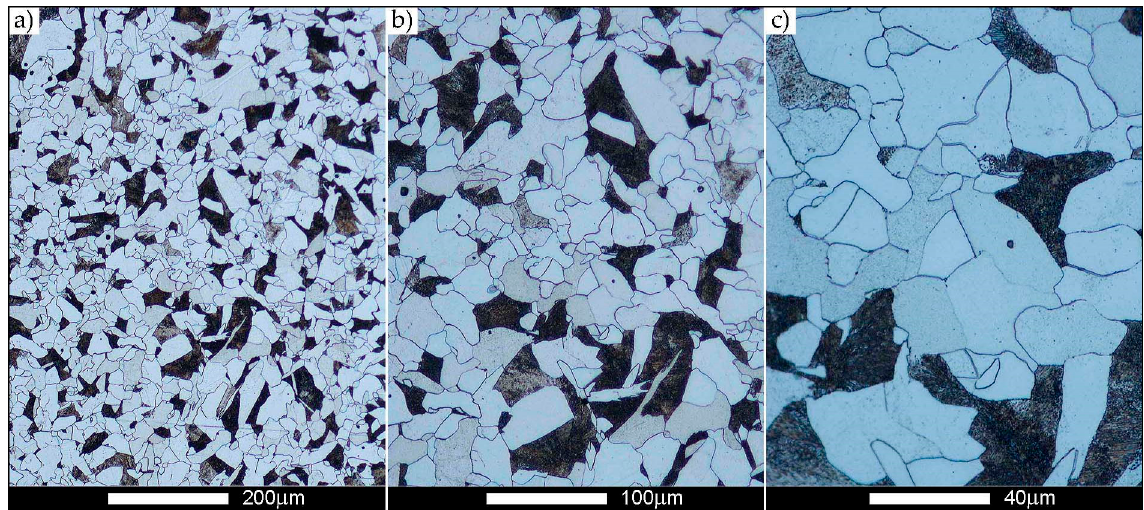
Figure 60. Welded joint microstructure of Hardox 450 steel with visible prior austenite grain boundaries, austenitised at 1000 °C—HAZ zone. ( a ) 100×; ( b ) 200×; ( c ) 500×.